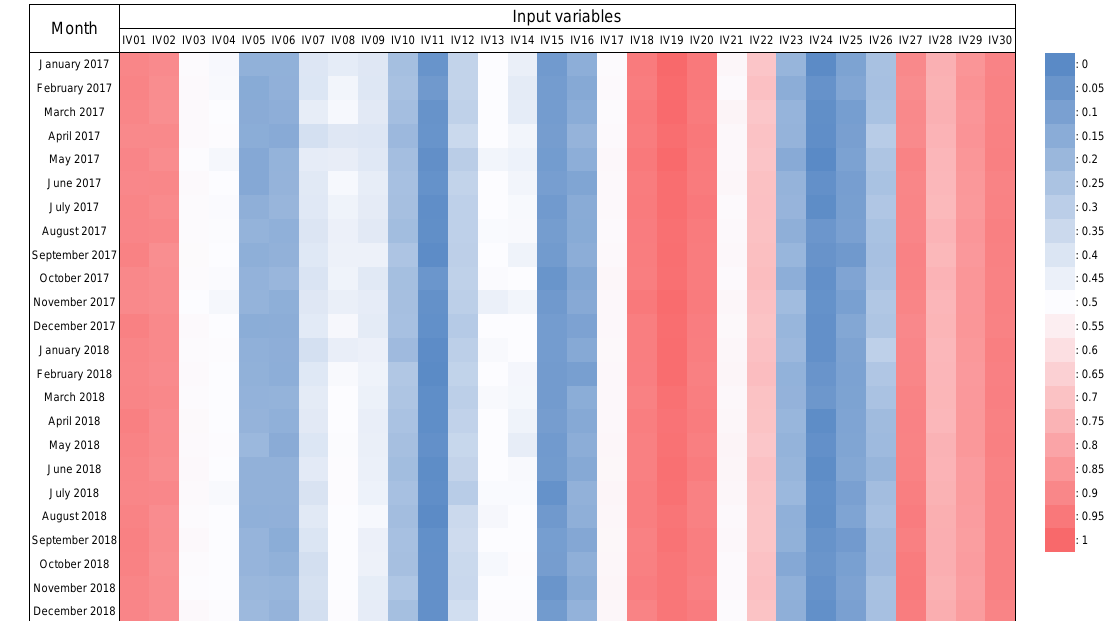
Figure 14. Result of feature importance via time-series cross-validation using the input variables in Table 2 for Ildo-1. A cooler color indicates a lower feature importance value, whereas a warmer color indicates a higher feature importance value.